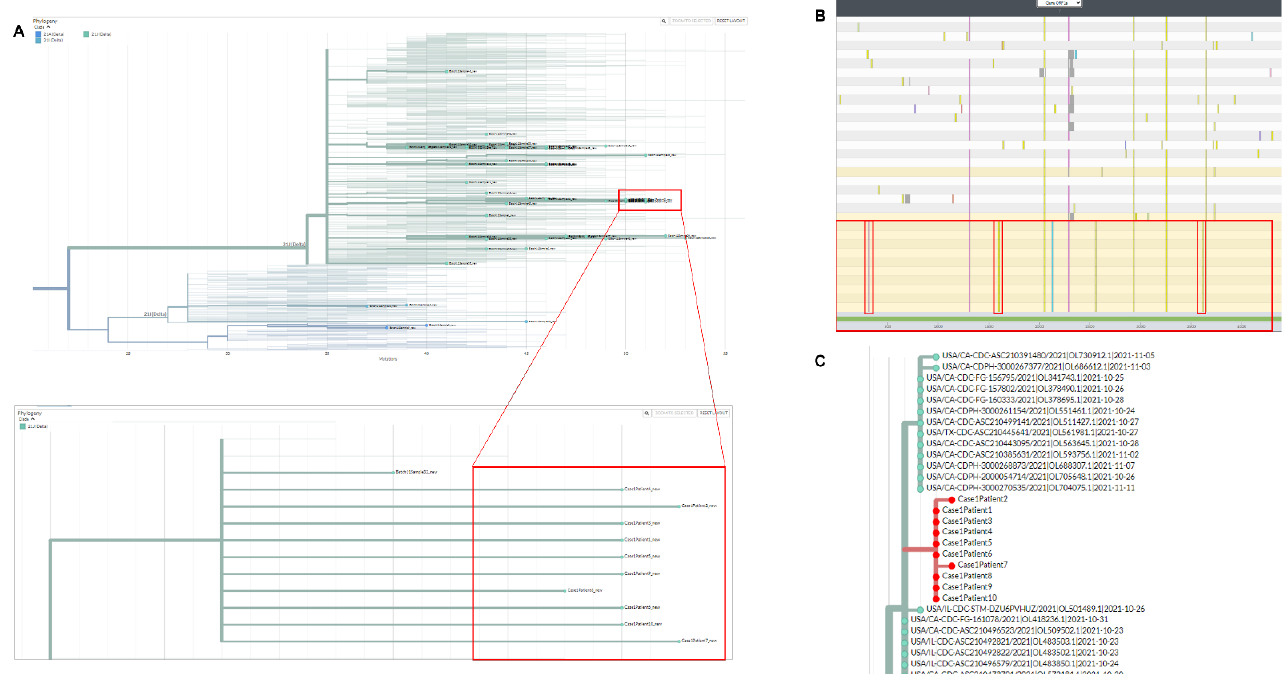
Figure 1. Phylogenetic and molecular analysis for outbreak case-1. ( A ) Nextclade phylogenetic clustering (cases highlighted by red boxes). ( B ) Nextclade gene viewer for CoV-2 ORF1a. Unique mutations are highlighted in red. ( C ) UShER analysis/clustering for outbreak samples with placement near most similar CoV-2 sequences.